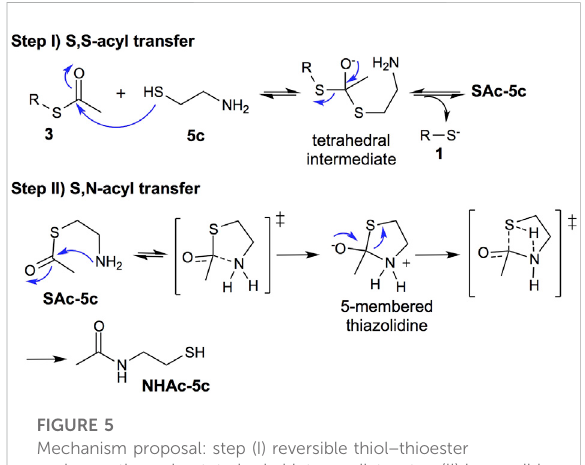
FIGURE 5 Mechanism proposal: step (I) reversible thiol − thioester exchange through a tetrahedral intermediate; step (II) irreversible thiazolidine intermediate to S,N-acyl transfer